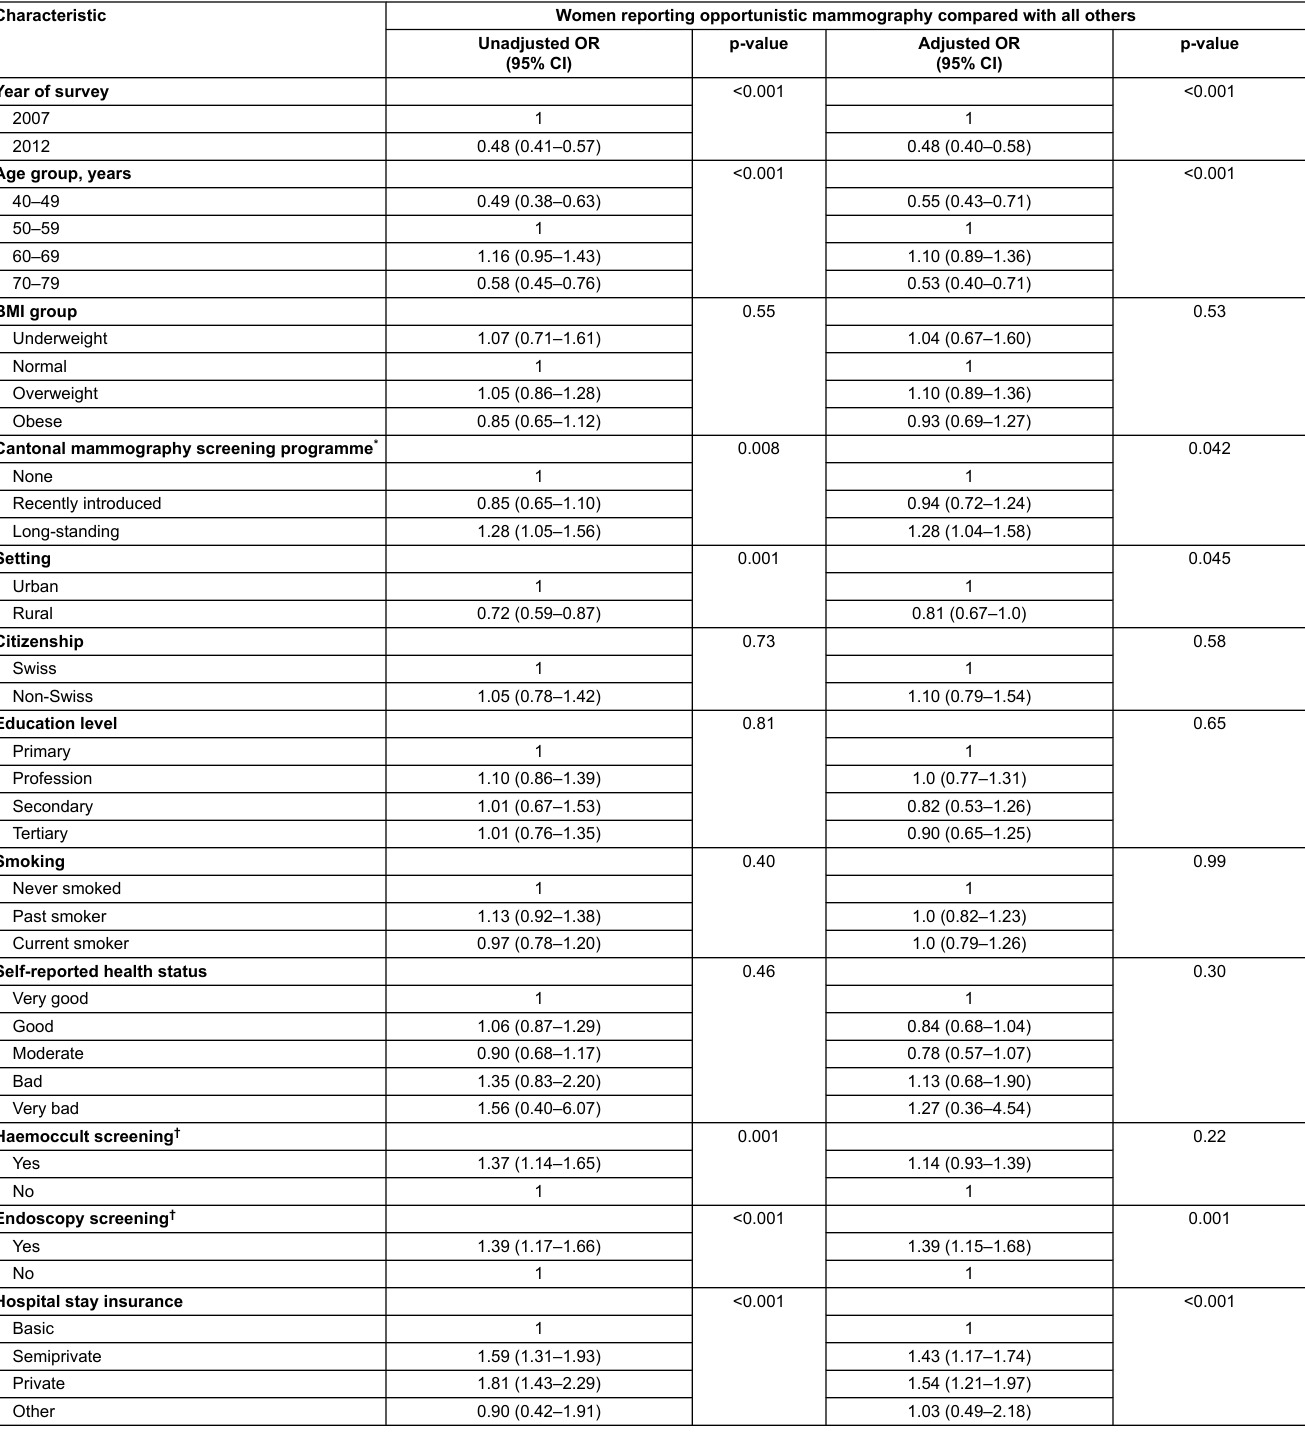
Table S3: Associations of opportunistic mammography (screening without clinical symptoms) with sociodemographic characteristics and health-related factors compared with all other women aged 40–79 years in Switzerland, 2007 and